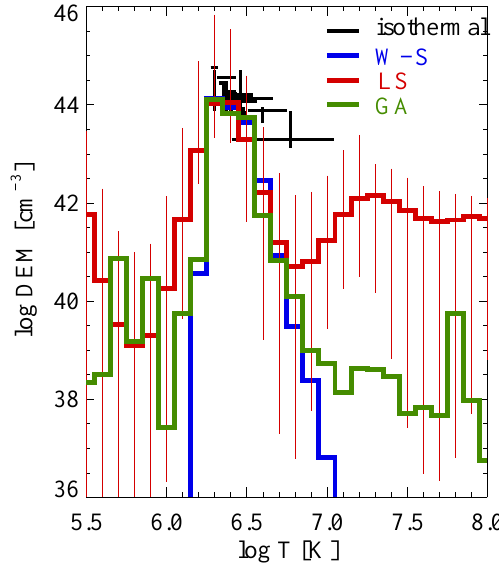
Fig. 7. The DEM distributions of the loop observed on 13 May 2007 obtained using the three analysed numerical methods and us- ing isothermal approximation with different filter